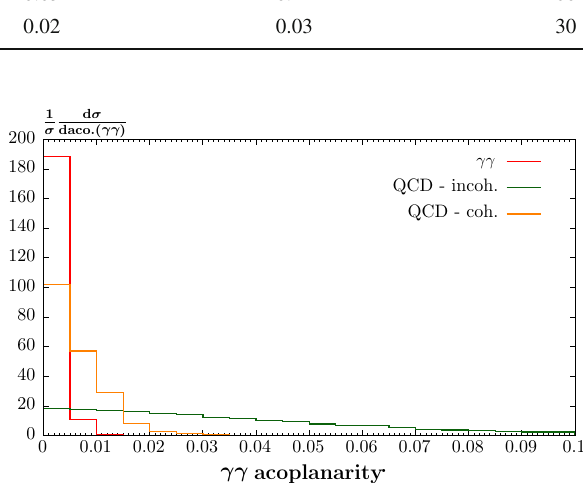
Fig. 9 Normalized differential cross sections for exclusive and semi- exclusivediphotonproductionwithrespecttothediphotonacoplanarity. The QED-initiated and QCD-initiated (both coherent and incoherent) processes are